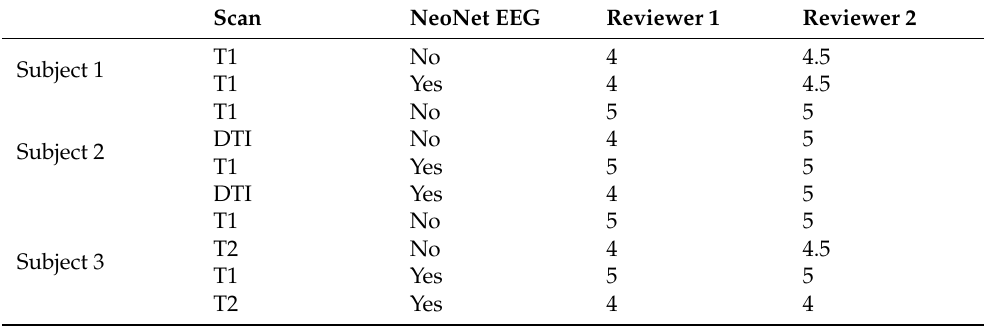
Table 4. Likert scale results from two board-certified neuro-radiologists comparing MR images with the NeoNet and NoNet conditions. The NoNet and NeoNet images were masked off to exclude skin and structures outside the skin to avoid the bias of detecting the presence of the EEG electrodes. Furthermore, the images of NeoNet and NoNet were double blinded and randomly presented to the